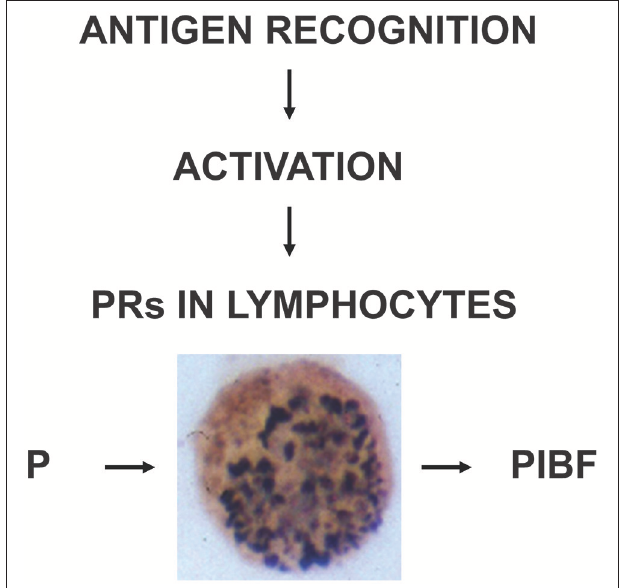
FIGURE 2 | The induction and biological significance of lymphocyte progesterone receptors. Following recognition of fetal antigens, maternal lymphocytes become activated and express progesterone receptors (PR). The presence of PRs enables the cells, to respond to progesterone (P), e.g., by PIBF